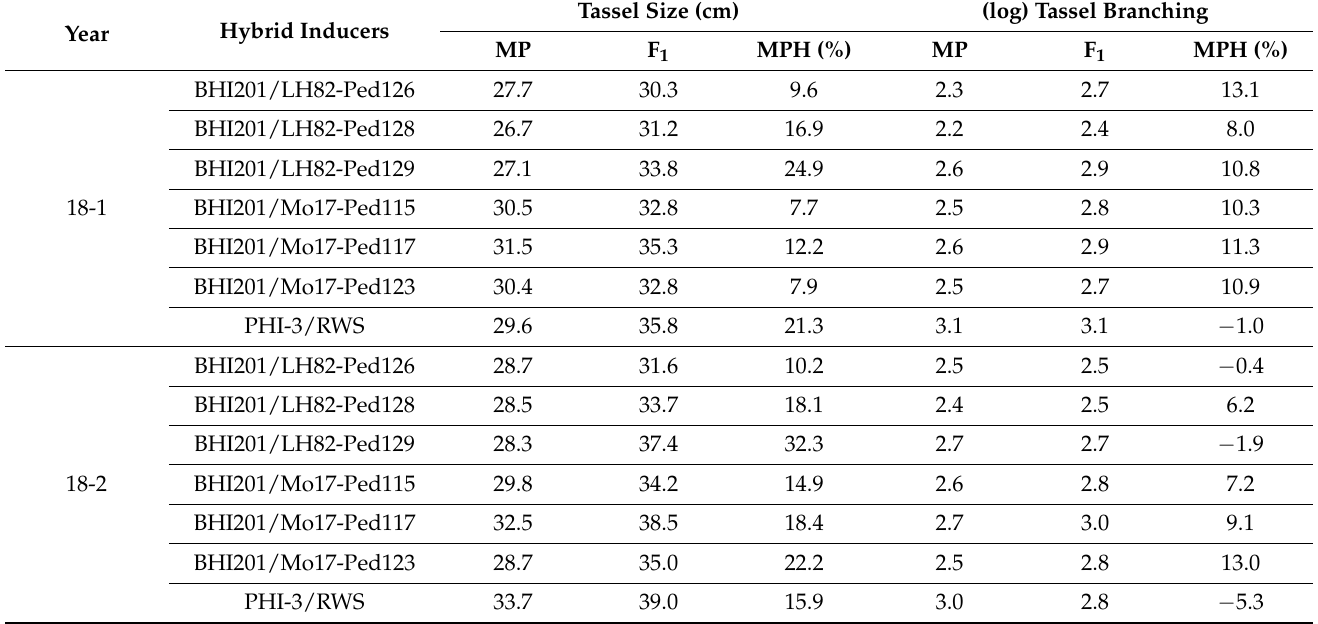
Table 4. Mid-parent (MP), hybrid mean (F1), and mid-parent heterosis (MPH) of hybrid haploid inducers on tassel size (cm) and tassel branching in